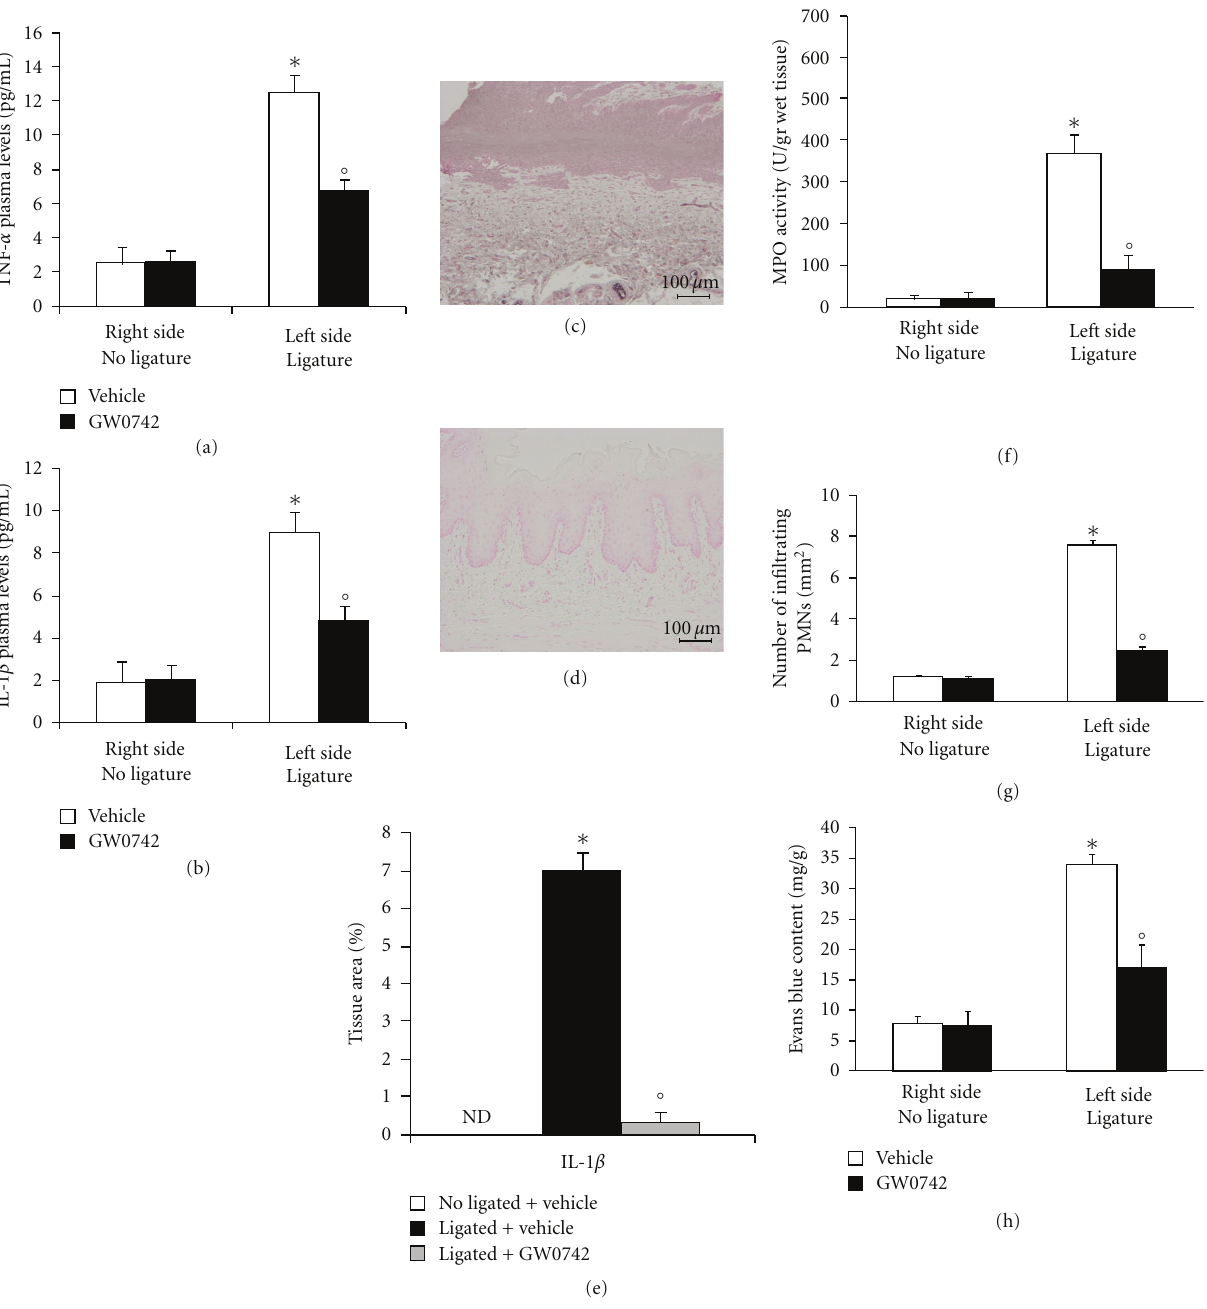
Figure 3: E ff ect of GW0742 on cytokines expression. At eight days after ligation, there was a substantial increase in TNF- α (a) and IL-1 β (b) formation when compared with gingivomucosal tissue sections taken from the contralateral side (a, b). In contrast, GW0742 treatment significantly reduced TNF- α (a) and IL-1 β (b) secretion. Immunohistochemical analysis of gingivomucosal tissues from ligated rats revealed positive staining for IL-1 β (c). In gingivomucosal tissue of GW0742-treated rats no positive staining was observed for IL- 1 β (d). Densitometry analysis of immunocytochemistry photographs ( n = 5 photos from each sample collected from all mice in each experimental group) for IL-1 β was assessed (e). Myeloperoxidase activity (f), the total number of infiltrating leukocytes (g) and the Evans blue content (h) in gingivomucosal tissue were significantly increased by ligature compared to the contralateral side. GW0742 significantly reduced Myeloperoxidase activity (f), the total number of infiltrating leukocytes (g) and the Evans blue content (h). Data are means of mean ± S.E.M. from N = 10 rats for each group. ∗ P < 0 . 01 versus nonligated. ◦ P < 0 . 01 versus